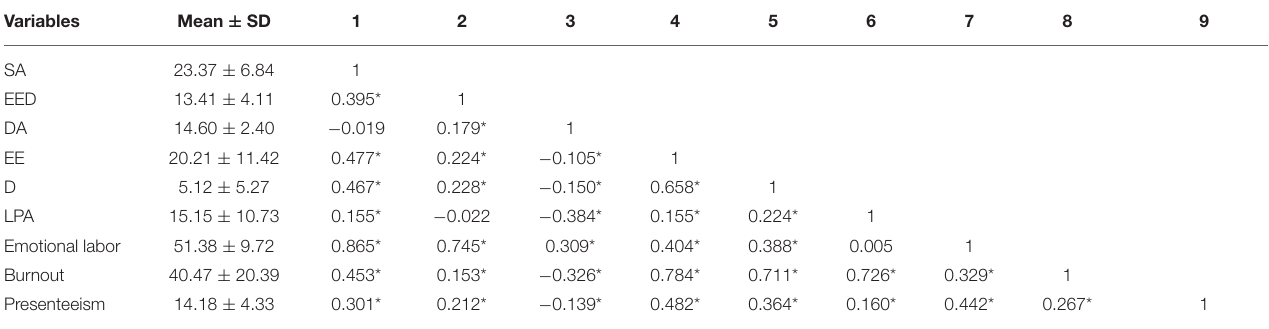
TABLE 2 | Means, standard deviations, and correlations for all variables. Variables